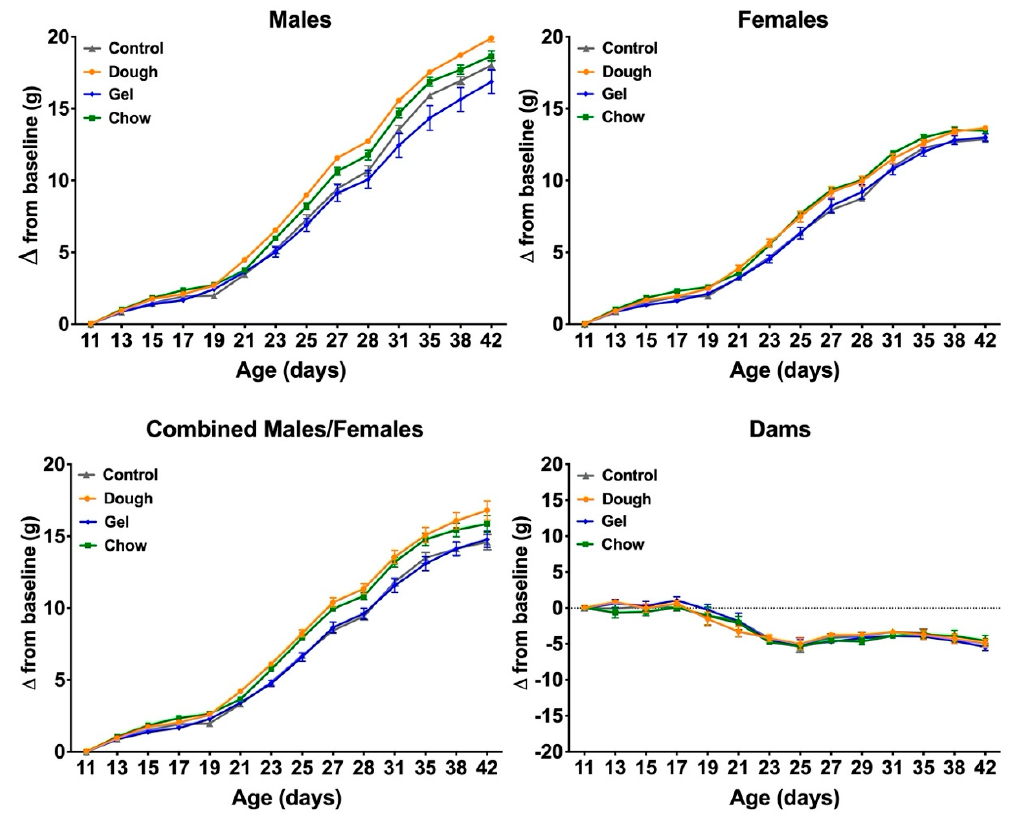
Figure 3. Body weight comparison with control by treatment group. Symbols indicate the average weight from baseline (P11) by postnatal day and error bars indicate SEM. Dough (orange), Gel (blue), and Chow (green) as compared with controls (grey) and stratified by sex. Assessment of growth trends revealed the Dough slope (0.63 ± 0.01, intercept = 2.83, R 2 = 0.88, p < 0.0001) and Chow slope (0.60 ± 0.01, intercept = 2.89, R 2 = 0.90, p = 0.0095) were significantly higher than the control group slope (0.55 ± 0.01, intercept = 1.81, R 2 = 0.90), while Gel was not significant. When the growth trend was stratified by sex, males consuming the Dough supplement had a significantly higher slope (0.74 ± 0.01, intercept = 4.8, R 2 = 0.96, p = 0.0027) and males consuming the Gel supplement had a significantly lower slope (0.61 ± 0.02, intercept = 4.0, R 2 = 0.87, p = 0.0331) when compared with male controls (0.67 ± 0.02, intercept = 4.5, R 2 = 0.95), and Chow was not significant. 3.2. Time to Consumption for Pups Gastric transit time in mice varies depending on the composition of the diet consumed, the strain of mouse, the population of gut microbial flora, and the measurement technique (e.g., observation of markers via imaging, chemical labels, or indigestible dye marker) [29–32]. The total transit gastrointestinal time reported in mice is between 6–8 h [31], so for the purpose of this study, time to consumption was recorded as the day in which dyed feces were observed in each supplemented mouse. Different types of supplements did not alter overall consumption, and practically all pups consumed the supplement by day 23 regardless of type. The proportion of pups consuming the supplement was 100% for Dough, 100% for Gel, and 96% for Chow. The median (minimum– maximum) time (days) for pups to start the test supplements was 19 (15–23) for Dough, 19 (15–21) for Gel, and 20.5 (17–22) for Chow (Figure 4). Log-rank test results for between-group differences in time to supplement use were calculated, and dough and gel supplements were consumed earlier in a higher proportion of animals when compared with moist chow supplements ( p = 0.0091).